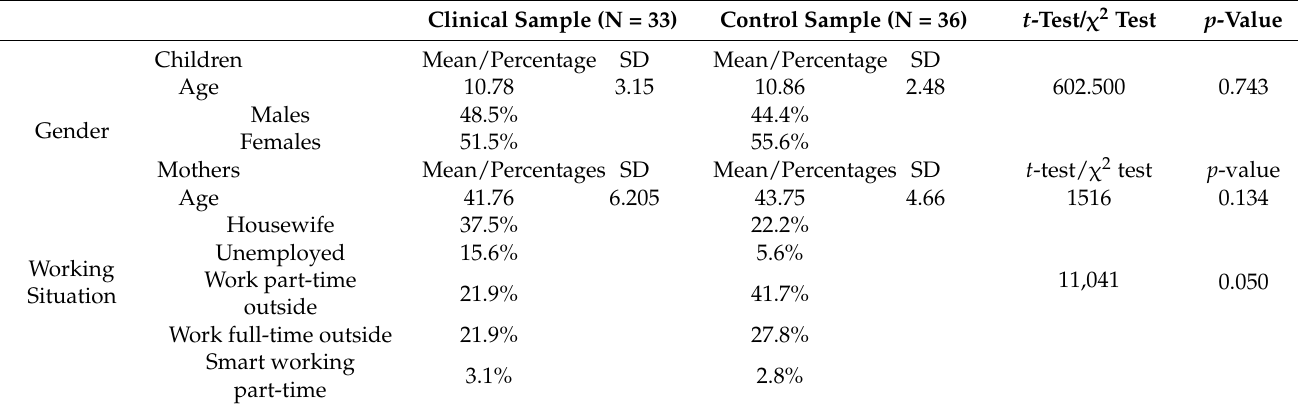
Table 1. Demographics and descriptive variables for the clinical and control group (means, standard deviations, and percentages). Student’s t -tests to compare the two groups are reported. Clinical Sample (N = 33) Control Sample (N = 36) t -Test/ χ 2 Test p